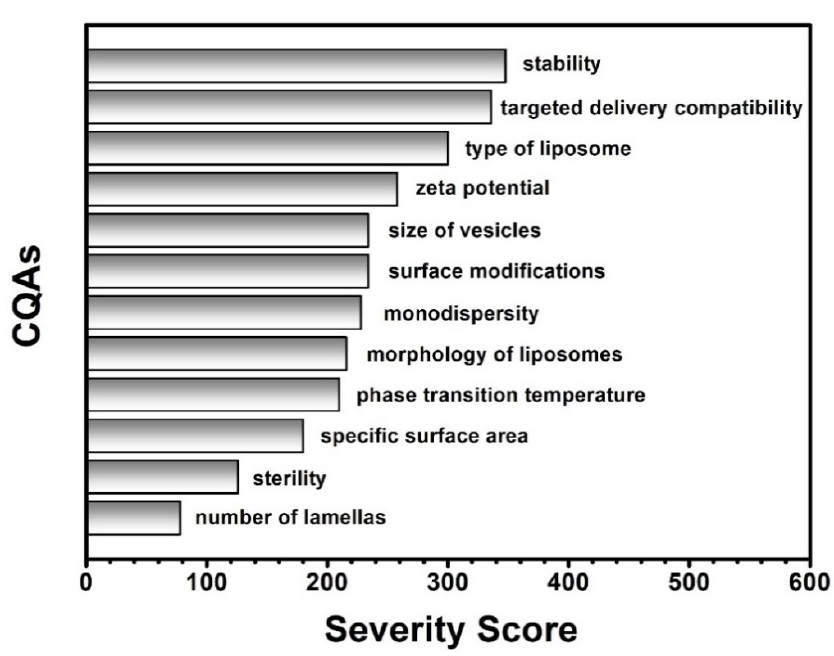
Figure 2. List of the Critical Quality Attributes (CQAs) of the liposomes ranked by their calculated severity scores.